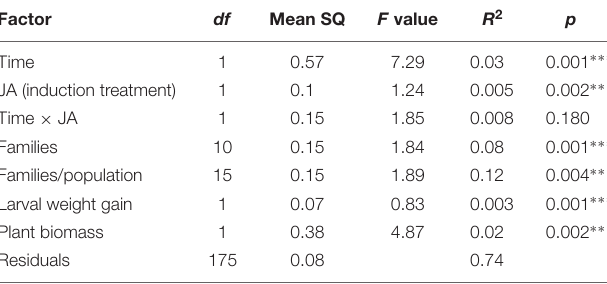
TABLE 1 | Two-way permutation ANOVA table for measuring the effect of JA induction in roots and time after induction on the GSLs matrix of Cardamine hirsuta